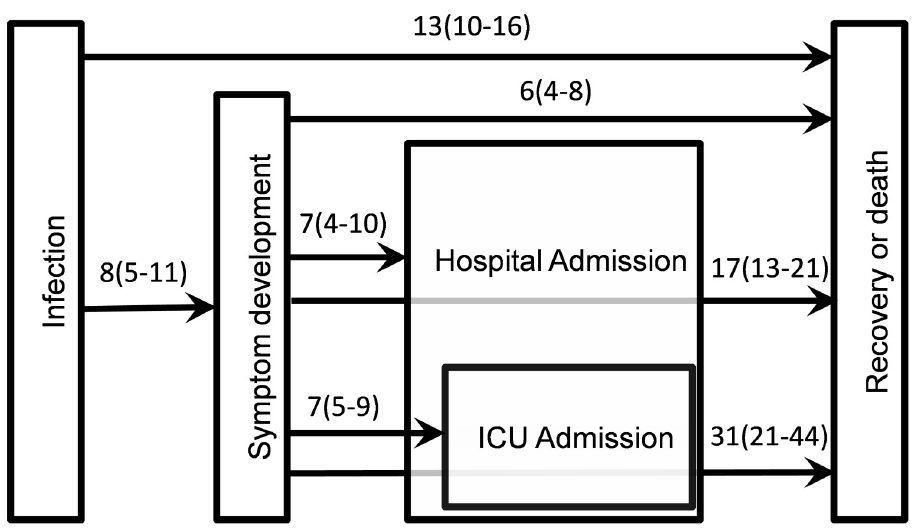
Fig 2. Medians and Interquartile Ranges (IQR) for the main disease events. Medians and IQRs for hospital and ICU admissions and recoveries have been obtained from SENTINEL and are measured in days elapsed from the onset of symptoms, which is assumed to coincide, on average, with the confirmation